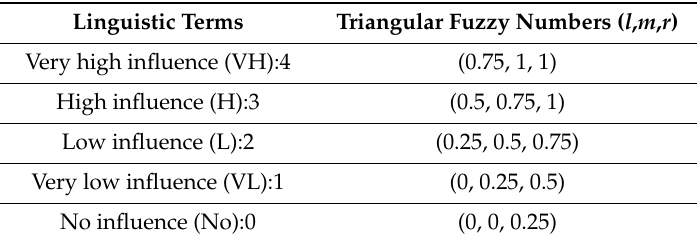
Table 2. Linguistic terms and corresponding triangular fuzzy